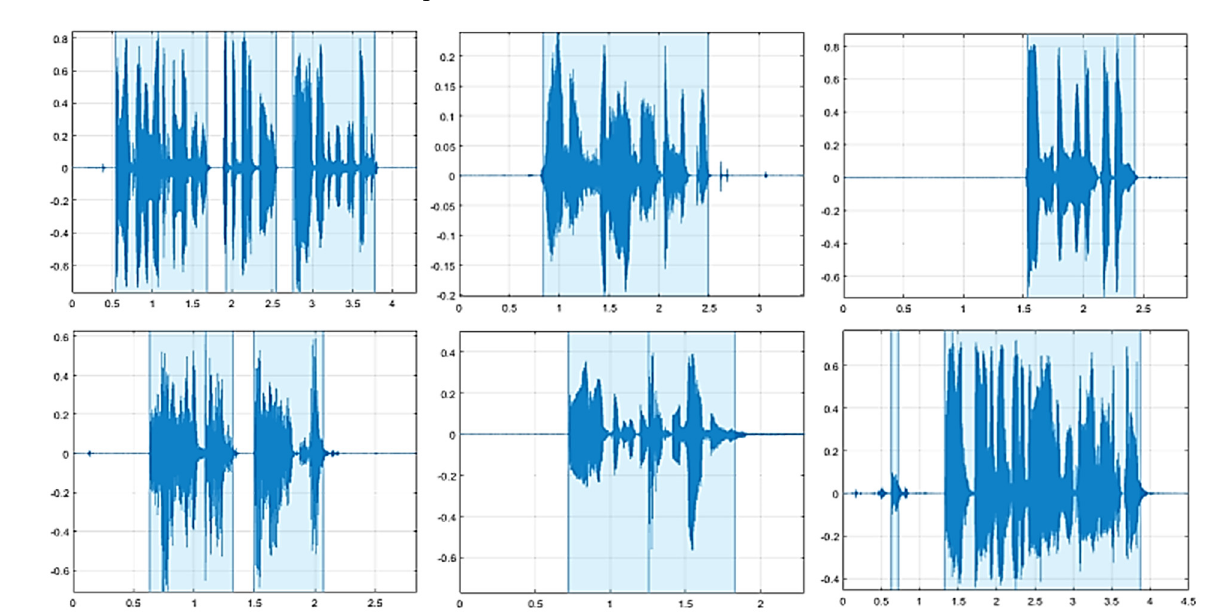
Figure 2. Data preprocessing step.